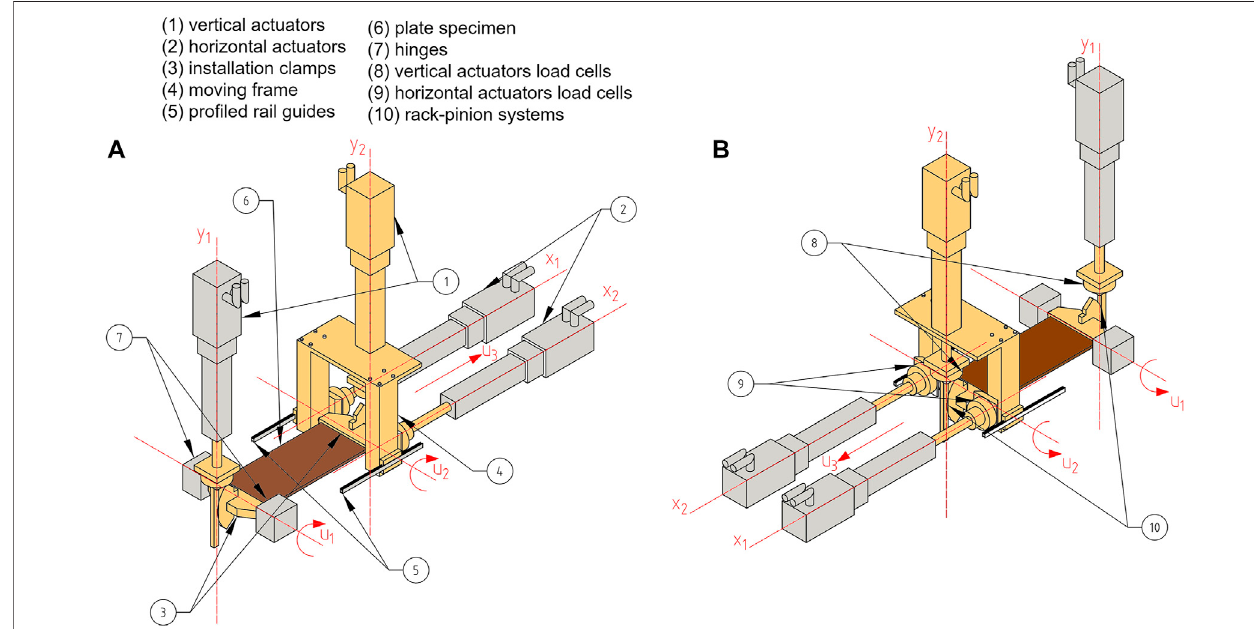
FIGURE4| Axonometric viewsofthe3-DoFHStestrigwithitsmaincomponents(themovingpartsarecoloredinyellow,theplatespecimenisbrown,whilethose parts fi xed to the reaction frame are gray): (A) front and (B) back view perspective.